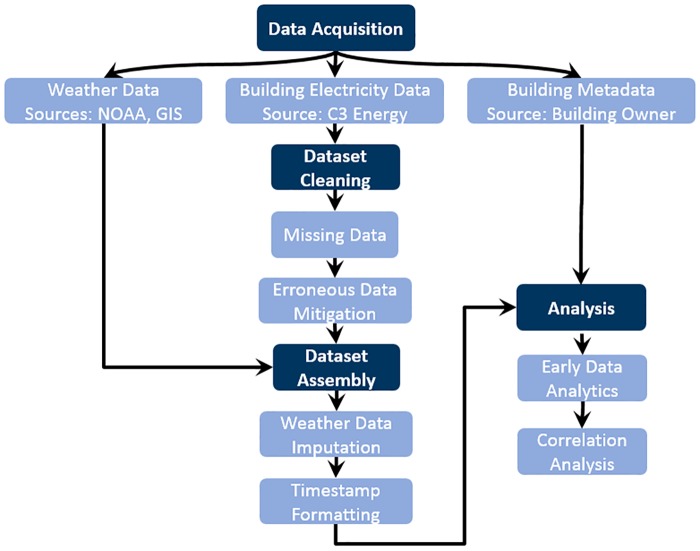
Data analysis flow chart.Data analysis flow chart of described methods and analyses.